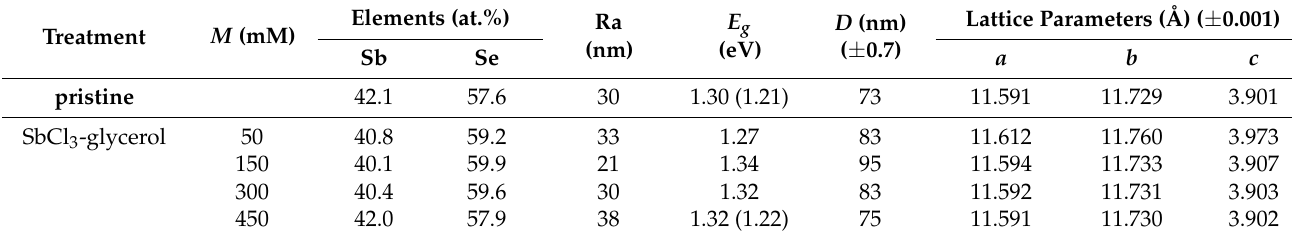
Table 1. The atomic percentages of antimony and selenium according to the EDX data, the arithmetic average of the absolute values of the surface height deviations ( R a ) according to the AFM data, optical direct band gap values ( E g ), the average crystallite size (D), and lattice parameters of Sb 2 Se 3 films depending on the molarity (M) of SbCl 3 in glycerol. Each parameter was determined by averaging the values obtained three measurements for each sample. The error represents the standard deviation. Treatment pristine SbCl 3